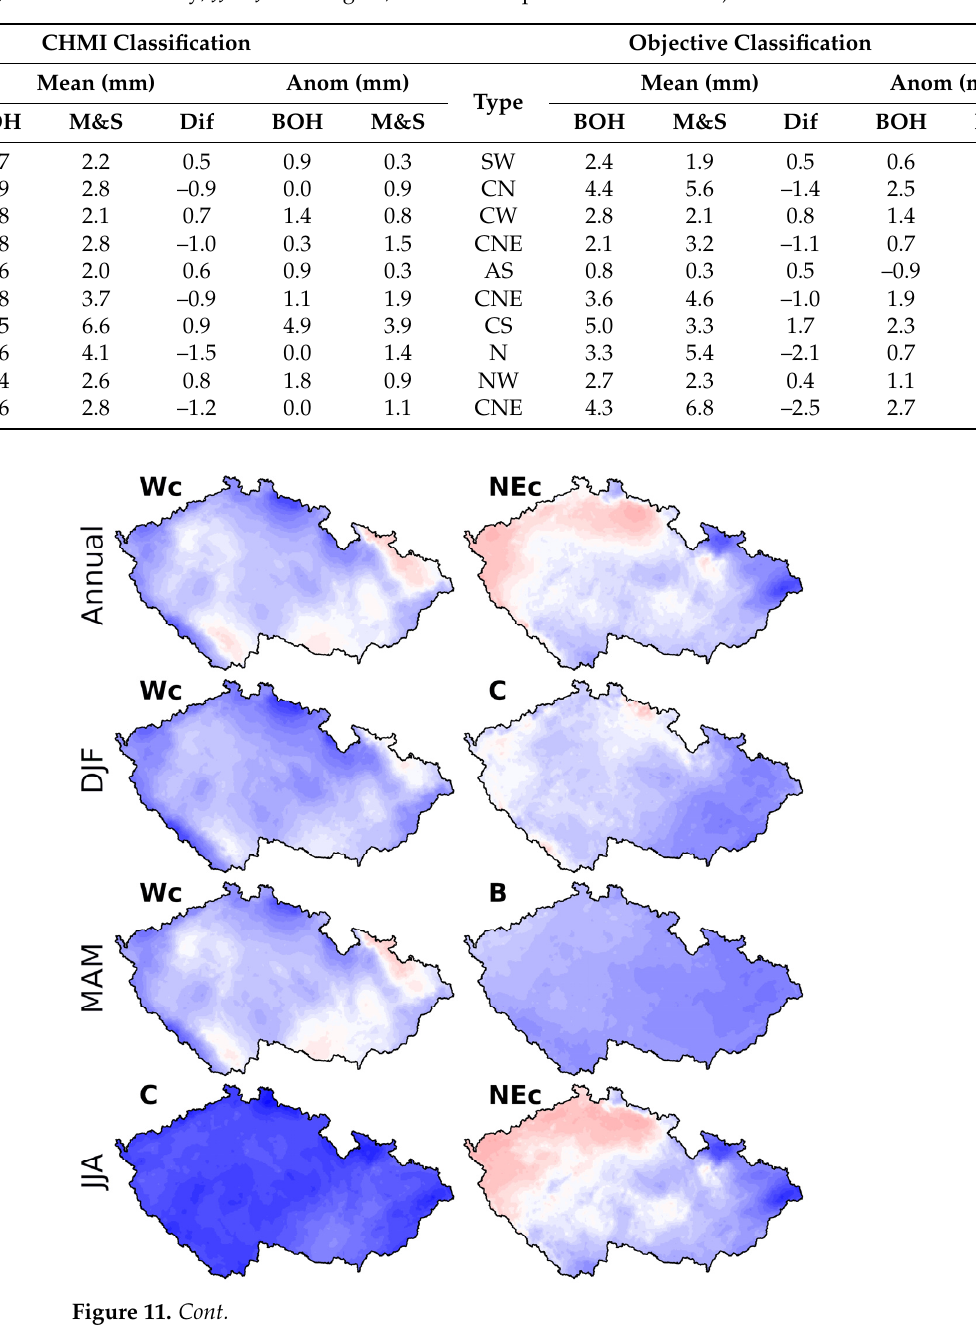
Table 1. Circulation types under the CHMI and objective classifications with the largest positive and negative differences (Dif) in the mean daily precipitation totals between Bohemia (BOH) and Moravia and Silesia (M&S) and anomalies (Anom) in the mean daily totals for a given type in regard to the corresponding overall annual (Ann) and seasonal (DJF: